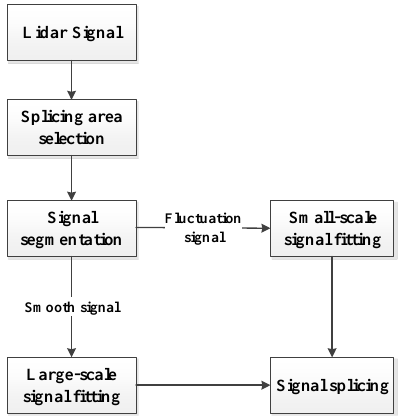
Figure 5. Flow chart of piecewise nonlinear splicing algorithm.